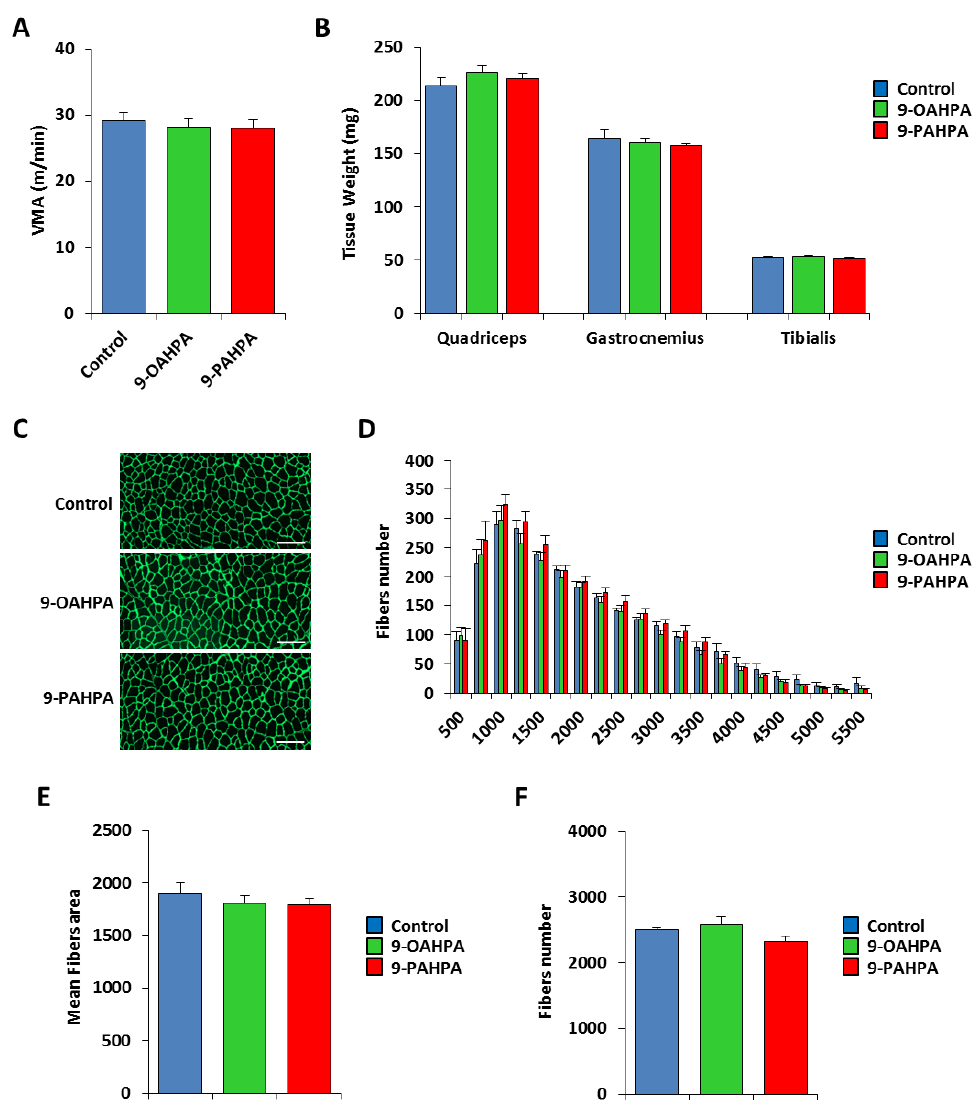
Figure 6. Influence of long-term intake of 9-OAHPA and 9-PAHPA on skeletal muscle phenotype of C57BL / 6J mice. ( A ) Maximal aerobic speed ( n = 10 for each group). ( B ) Quadriceps, gastrocnemius, and tibialis muscles weight ( n = 10 for each group). ( C ) Representative anti-laminin staining on cryosections of tibialis muscles. Scale bar, 200 μm. ( D ) Fiber size distribution in tibialis muscles ( n = 10 for each group). ( E ) Mean fibers area ( n = 10 for each group). ( F ) Total fibers number ( n = 10 for each group). There is no statistical difference (Student’s t -test). Results are expressed as means ± SEM.